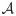
Flow-based multiscale partitioning of the connectome of C. elegans.Using Markov Stability, we detect flow-based partitions in this directed network at all scales. Here we show the medium to coarse Partitions A to E (top panel), found as optimal at the indicated Markov time intervals (see S1 Fig for the full sweep of Markov times). The Markov Time intervals corresponding to different robust partitions are indicated by different colour boxes. Partitions A–E are persistent, as signalled by their robustness over extended time plateaux in VI (t, t′)(heatmap in bottom panel), and robust with respect to the optimisation, as signalled by dips in the variation of information 〈VI(t)〉(grey line in bottom panel).